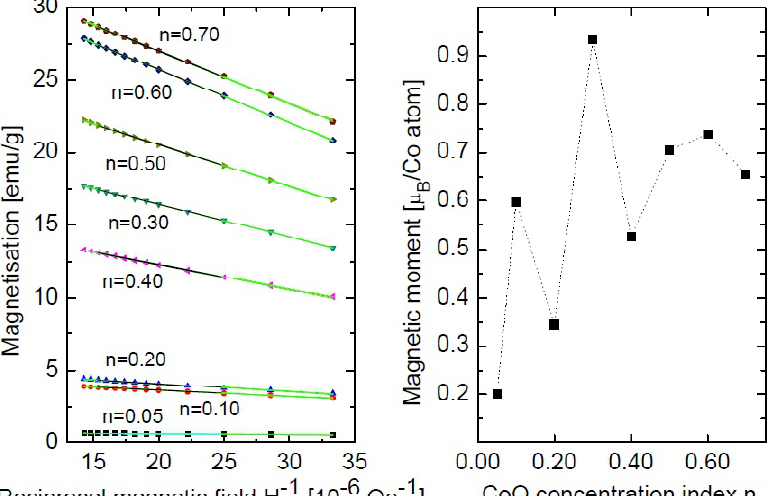
Fig. 11. (Left panel) Dependence of magnetisation on reciprocal magnetic field M ( H -1 ) obtained in strong ( H > 30 kOe) fields for all samples. (Right panel) Calculated effective magnetic moment of a single Co ion in samples with different composition index n